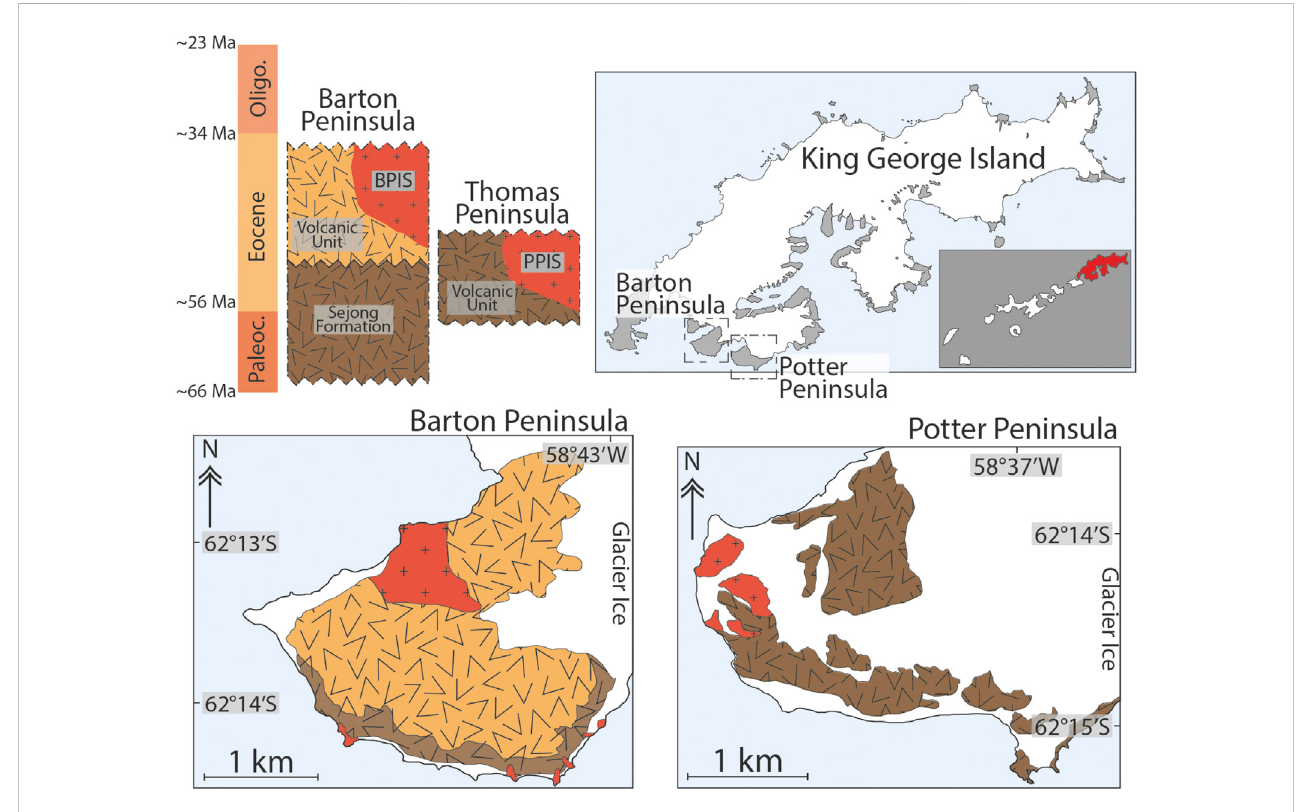
FIGURE 12 Geological map of Barton and Potter peninsulas, King George Island, modi fi ed from Kraus and del Valle (2008) and Lee et al.